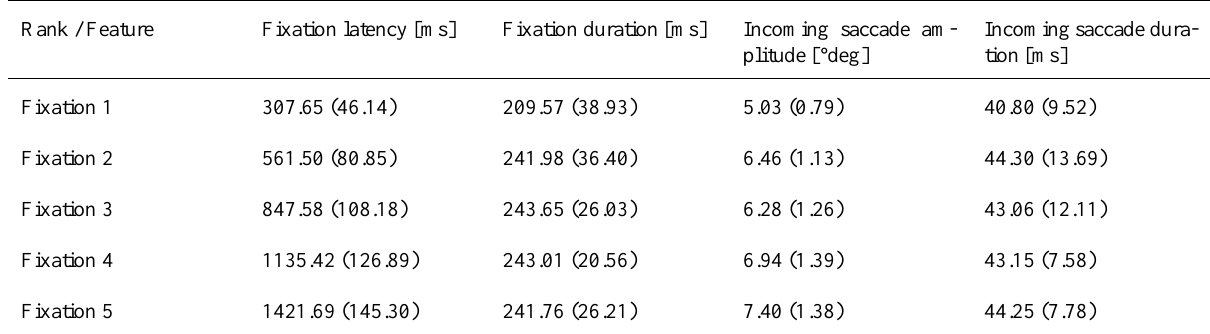
Table 2 Statistical summary for the first five fixations: latency, fixation duration, amplitude and duration of the incoming saccade, based on individual means (std), at the start of free exploration